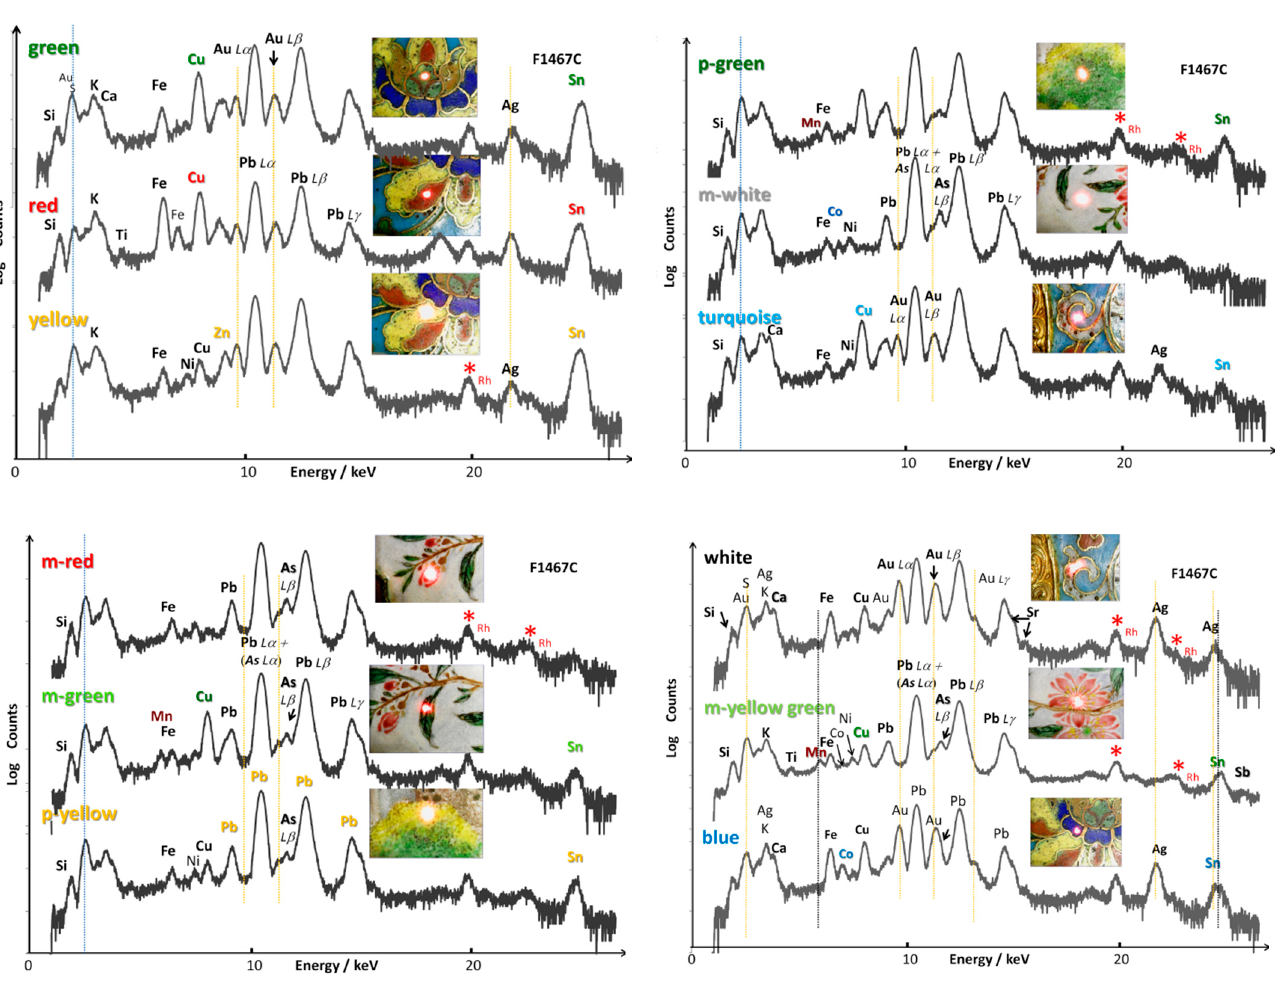
Figure 6. Representative pXRF spectra recorded on the different colored cloisonné (top-left: green, red and yellow; top-right: turquoise; bottom-right: white and blue) and painted (p-painted (large medallion) and m-(small) medallion) enamels of the gold ewer (white, yellow, red, green and yellow-green areas). Vertical lines serve as a guide for eyes to distinguish better the contribution of elements having peaks at very similar energy levels. Red stars (*) indicate the contribution of the instrument (Rh peaks).